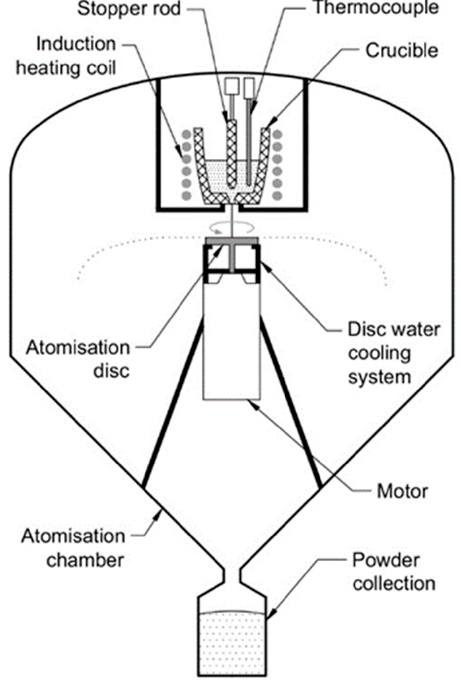
Figure 1. Schematic diagram of the centrifugal atomization equipment.